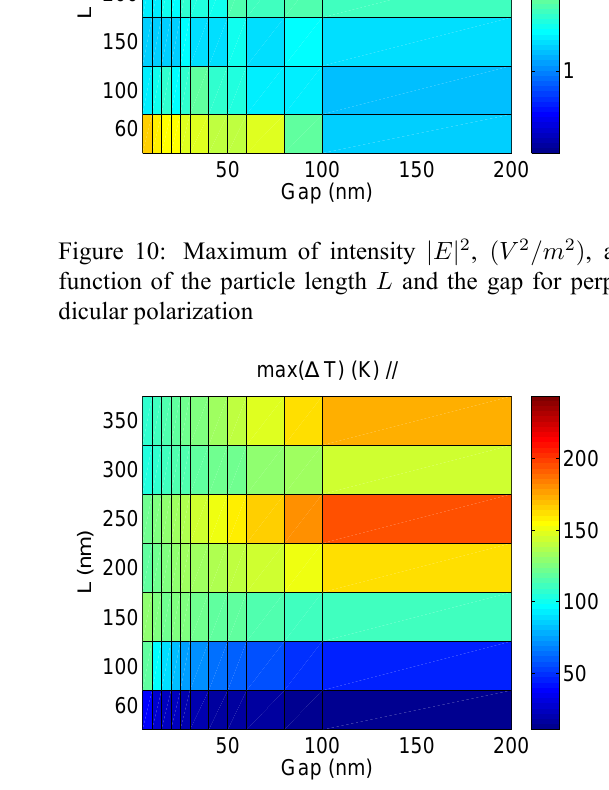
Figure 11: Maximum of elevation of temperature, ( K ) , as a function of the particle length L and the gap for parallel